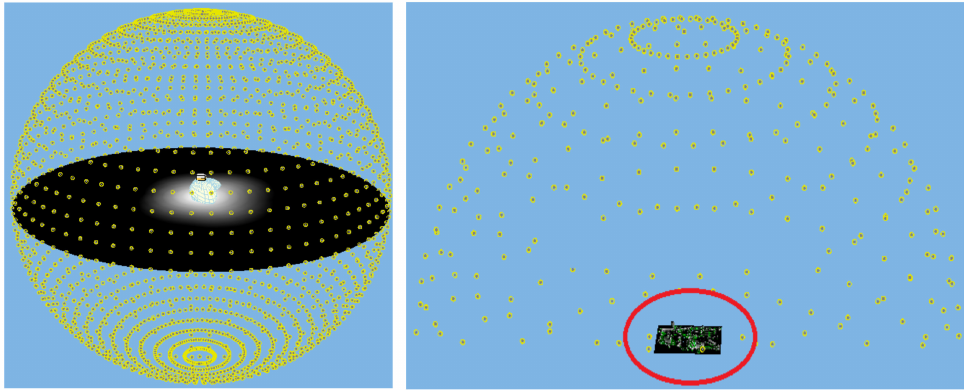
Figure 2. The grid of calculation points of a software goniophotometer for calculation of emission characteristics of outdoor lighting systems